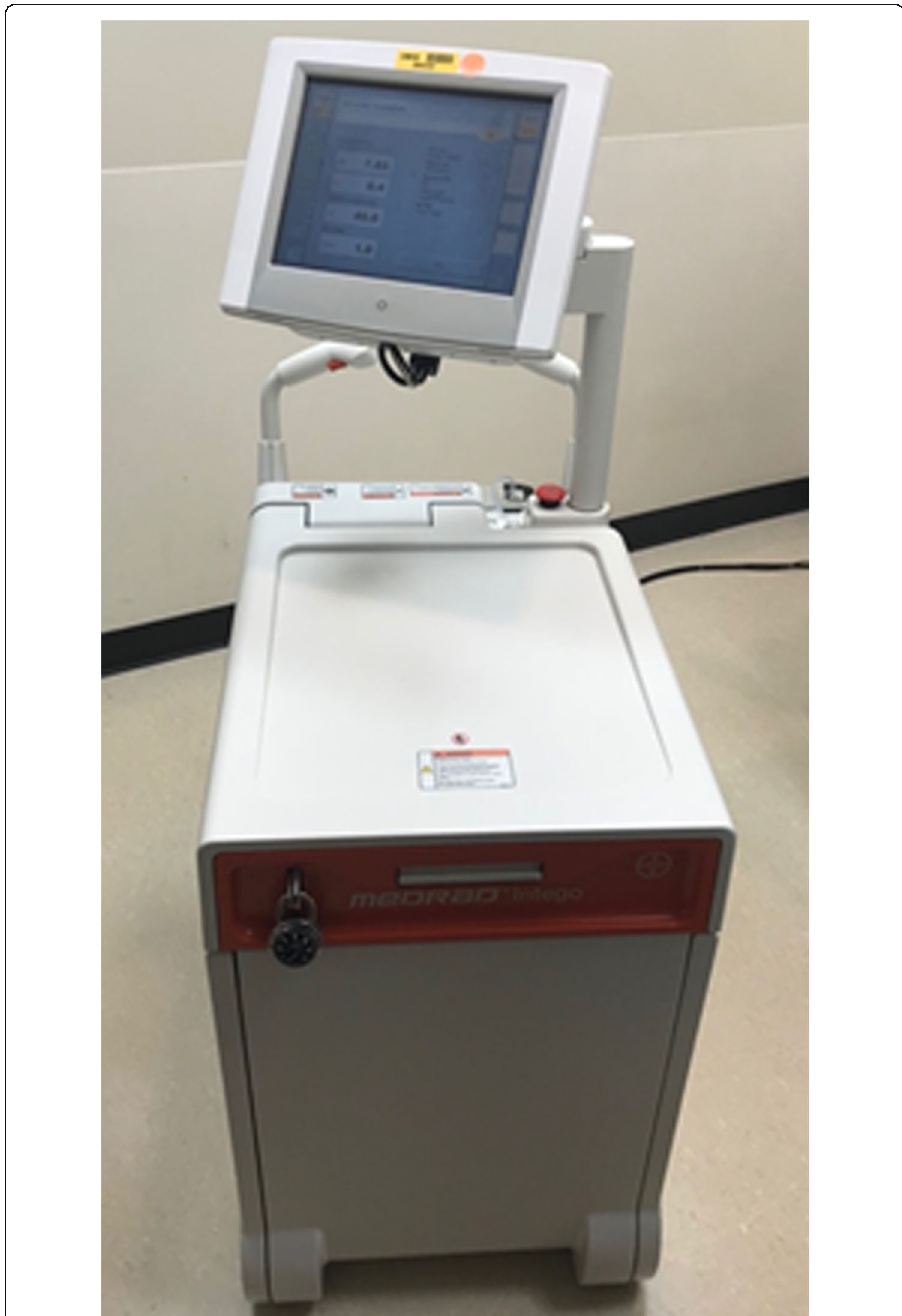
Fig. 5 Bayer Medrad® Intego PET Infusion